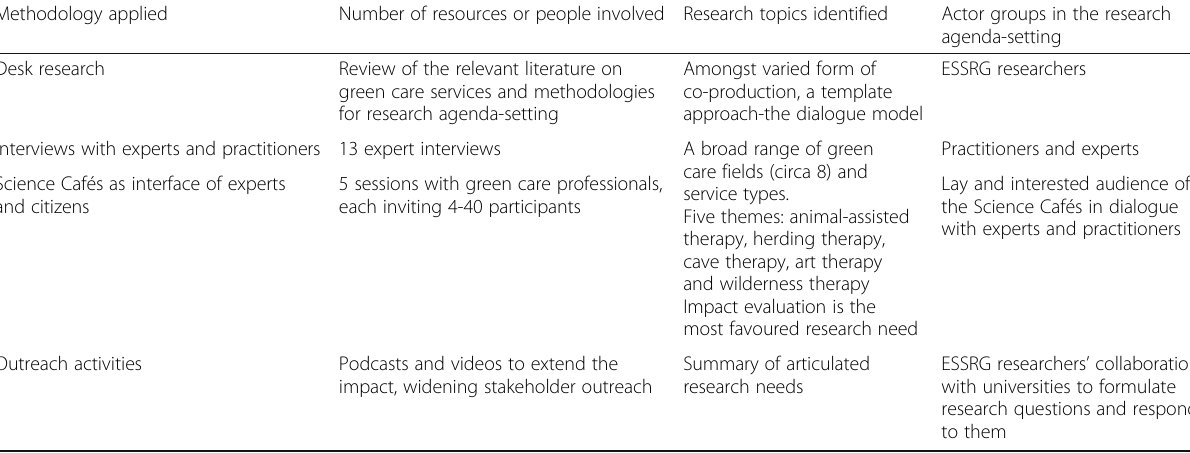
Table 1 Summary of the main empirical steps in the research agenda-setting process Methodology